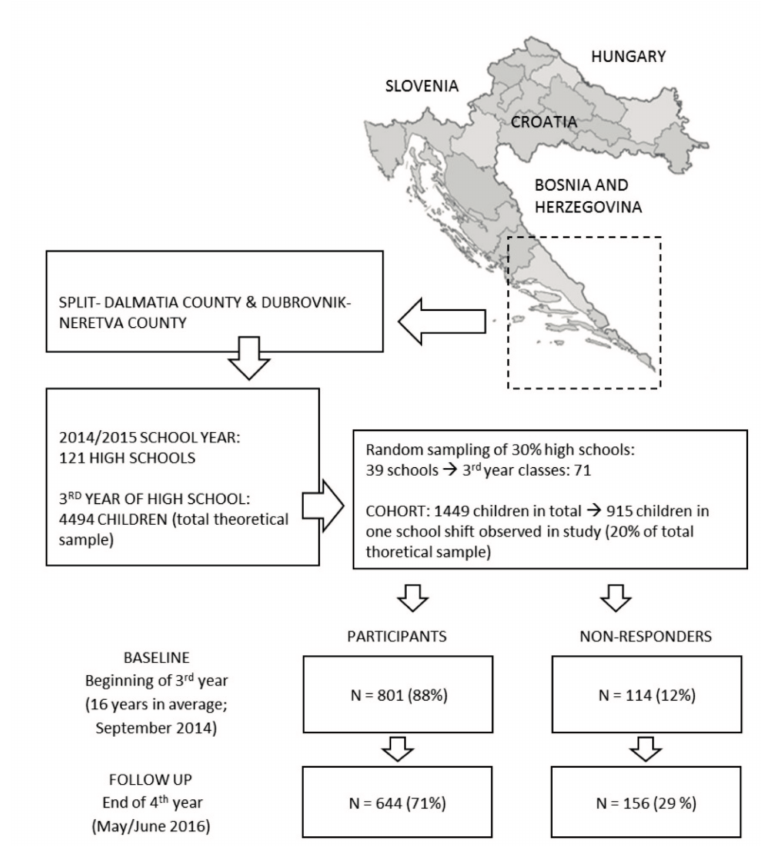
Figure 1. Location of the study, testing sequences, participant- and